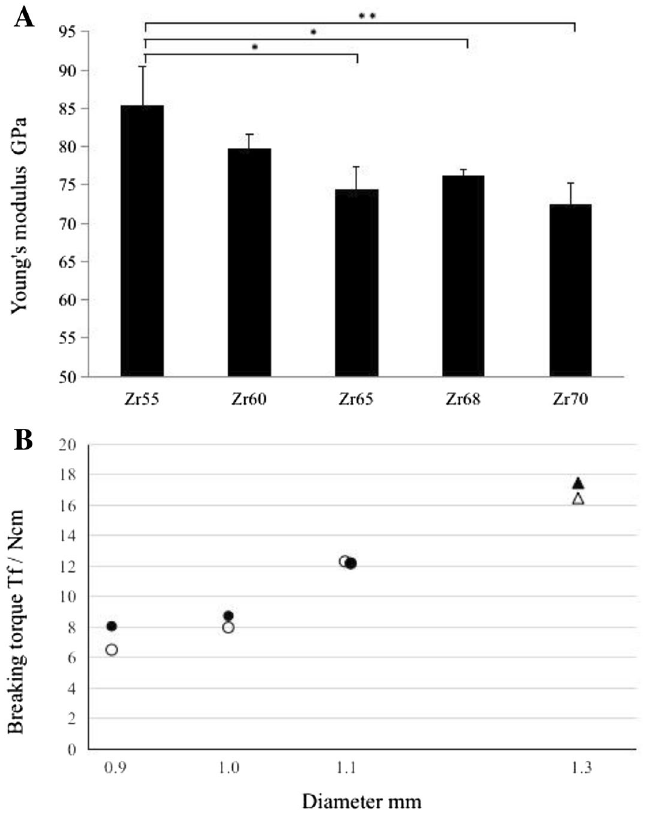
Figure 1. Young’s modules and torsion breaking torque test by a free resonance vibration method. A The measurement of Young’s modules by the free resonance vibration method of five types of Zr-based metallic glass rods (Zr 55 Ni 5 Cu 30 Al 10 , Zr 60 Ni 10 Cu 20 Al 10 , Zr 65 Ni 10 Cu 17.5 Al 7.5 , Zr 68 Ni 12 Cu 12 Al 8 , and Zr 70 Ni 16 Cu 6 Al 8 ). (n = 3 per group). ** P < 0.01, * P < 0.05. ( B ) The torsion breaking torque test of Zr 70 Ni 16 Cu 6 Al 8 BMG and Ti-6Al-4 V miniscrews unused and used for 8 weeks after implantation. △ :Ti-6Al-4 V unused miniscrew, ○ :Zr 70 Ni 16 Cu 6 Al 8 BMG unused miniscrew, ▲ :Ti-6Al-4 V miniscrew used for 8 weeks after implantation, ● : Zr 70 Ni 16 Cu 6 Al 8 BMG miniscrew used for 8 weeks after implantation (n = 3–5 per